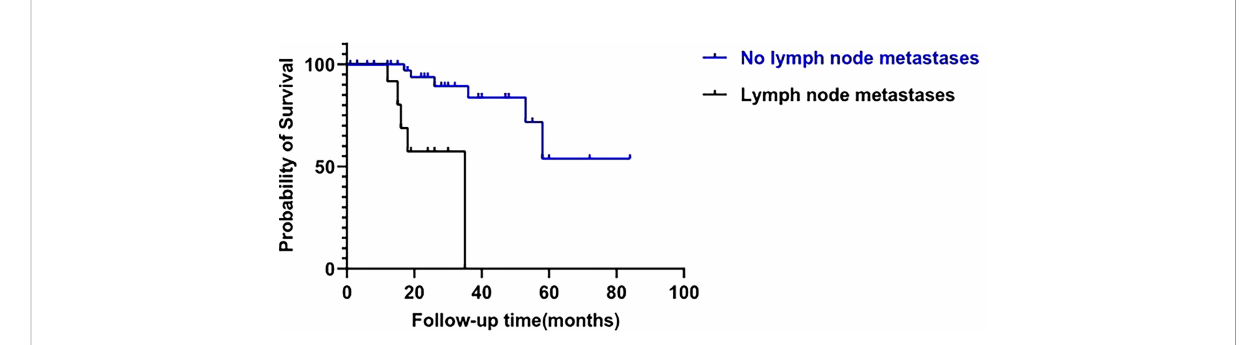
FIGURE 4 Impact of N stage on overall survival of fi stula-associated anal adenocarcinoma. (log-rank test;